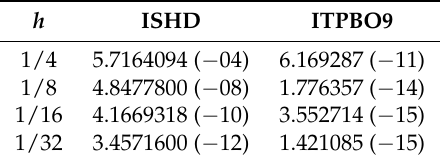
Table 3. Comparison of the maximum absolute errors on Problem 2, t ∈ [ 0,2 ]